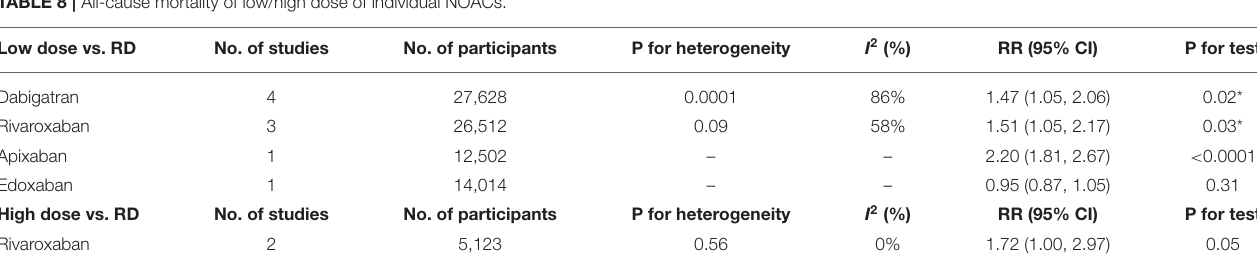
TABLE 8 | All-cause mortality of low/high dose of individual NOACs. Low dose vs.